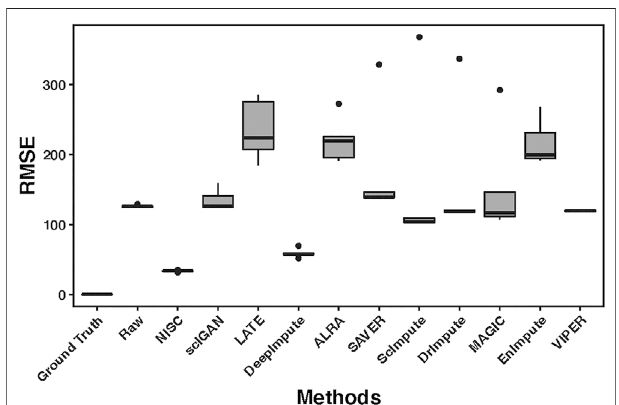
FIGURE 4 | RMSE (root mean square error) boxplots for the raw input and imputed data by each method. The RMSE is calculated between the ground truth and either the raw or imputed values. The raw dataset contains 800 genes and 1,000 cells in 4 cell types, with 90% sparsity, and is replicated 10 times. Detailed information about the RMSE can be found in the supplementary